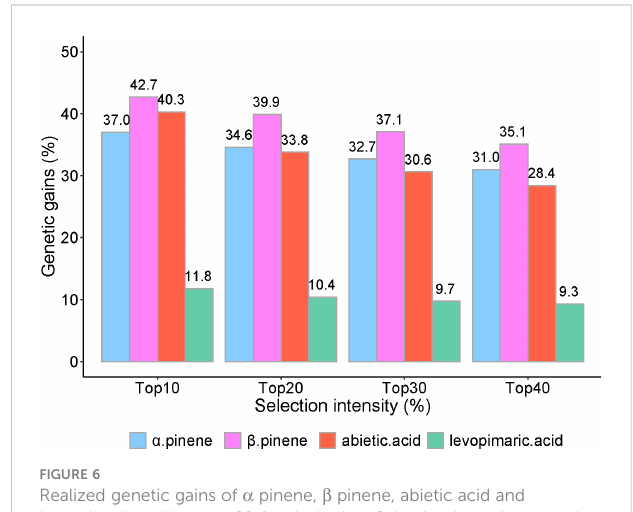
FIGURE 6 Realized genetic gains of a pinene, b pinene, abietic acid and levoprimaric acid at age 29 for slash pine. Selection intensity ranged from 10% to 40% of the 59 families; genetic gains were calculated as an improved percentage.